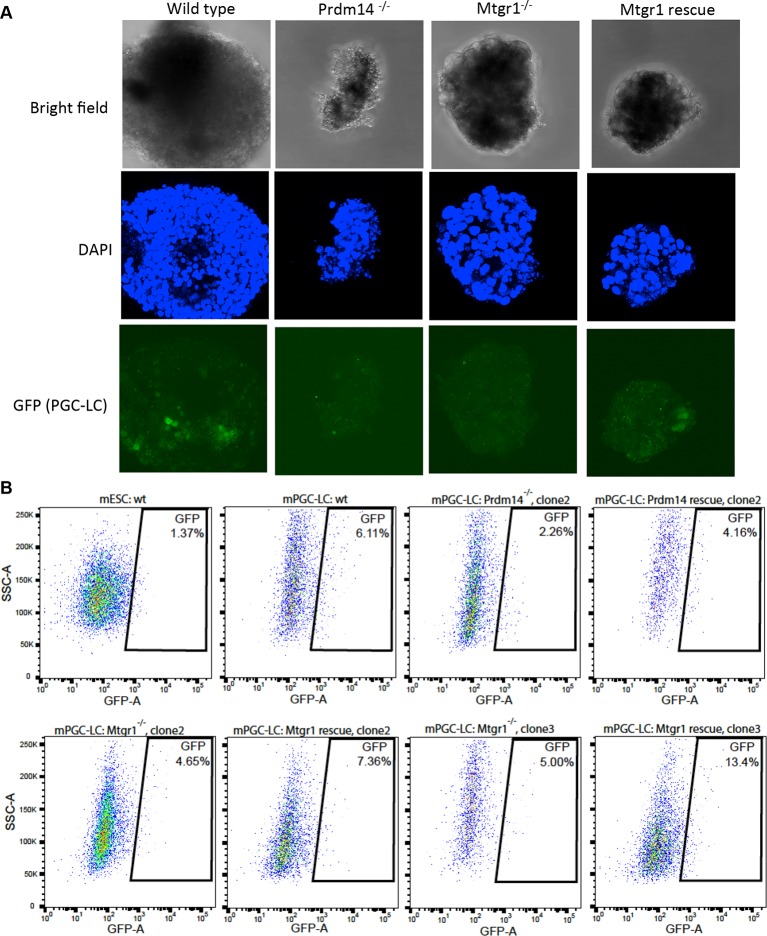
Expression of differentiation markers in embryoid bodies derived from wt or Mtgr1−/− ESCs.(A) RT-qPCRs analyses of indicated markers in EBs induced from wt or Mtgr1−/− ESCs and cultured for four days in suspension after LIF withdrawal; shown relative to wt mESCs cultured under serum+LIF conditions. (B) RT-qPCRs analyses of select markers in EBs induced from wt or Mtgr1−/− ESCs and cultured for eight days in suspension after LIF withdrawal; shown relative to wt mESCs cultured under serum+LIF conditions. ESCs, embryonic stem cells; LIF, leukemia inhibitory factor; Mtgr1, myeloid translocation gene related 1; RT-qPCRs, quantitative reverse transcription-polymerase chain reaction; wt, wild type.